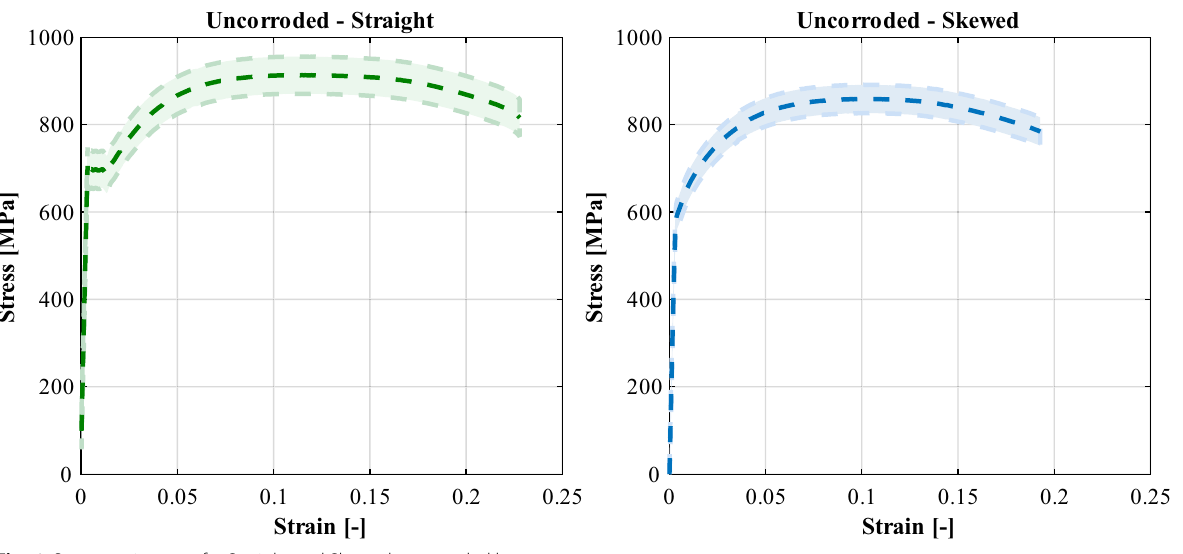
Fig. 6 Stress-strain curve for Straight and Skewed uncorroded